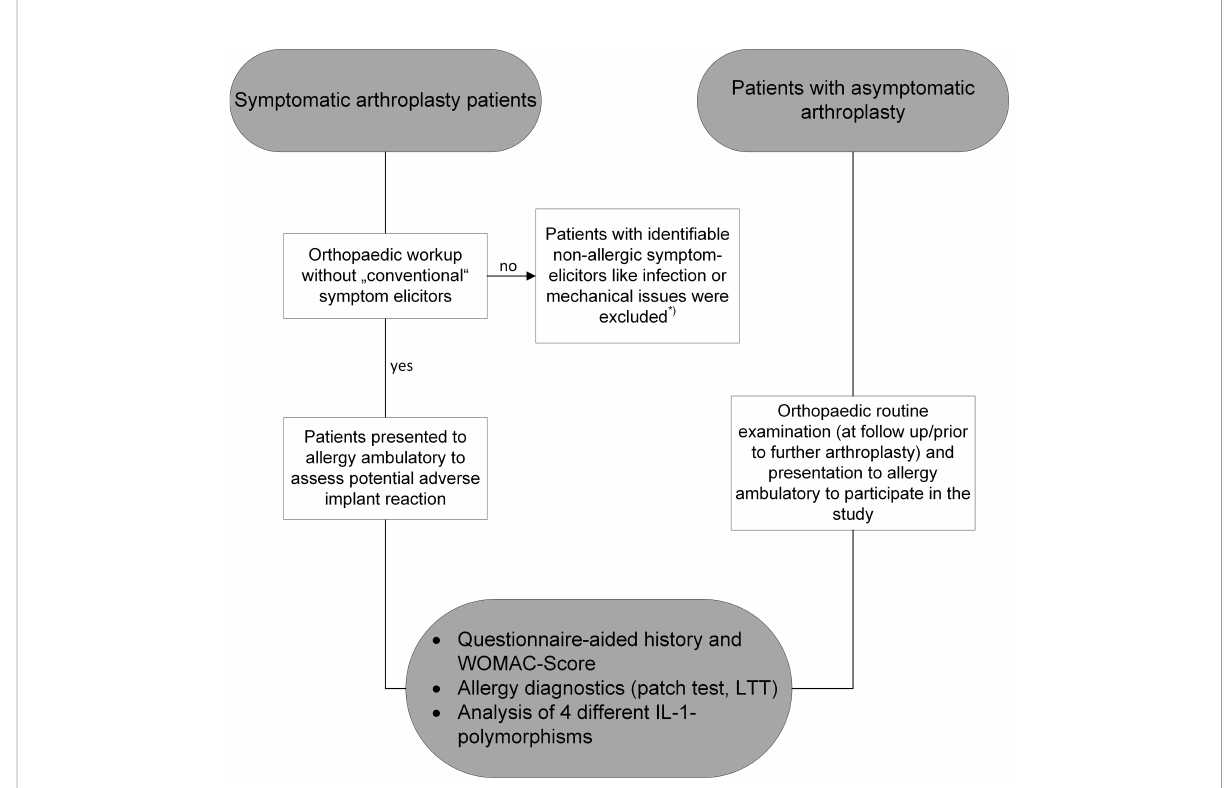
FIGURE 1 Schematic of the study design. The initial work-up for symptomatic arthroplasty was done by the treating orthopaedic surgeon. Once “ conventional ” problem elicitors like infection or mechanical issues were ruled out, patients were presented for allergy diagnostics and asked for consent to additional subsequent polymorphism analysis.*= i.e. therapy was performed according to the identi fi ed complication elicitors by the treating orthopaedic